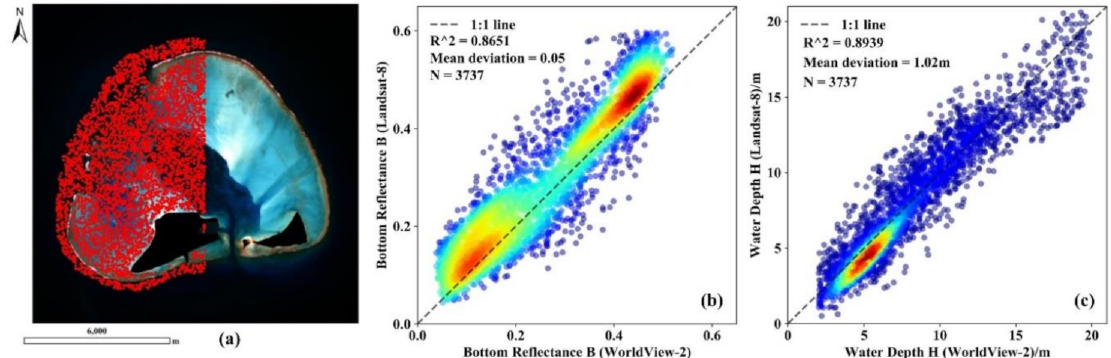
Figure 10. ( a ) Distribution of the sample points used to compare the inversion results in ( b , c ). ( b , c ) Scatter density maps of the bottom reflectance and bathymetry inverted by WorldView-2 and